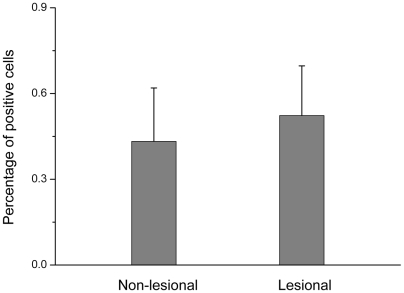
XBP1 protein level determined by immunohistochemical staining in the paired lesional and non-lesional skins from 37 patients with vitiligo.Data represent the percentage of positive cells. The comparison of XBP1 protein level between the 37 paired lesional and non-lesional skins was done by using Paired Samples T Test.